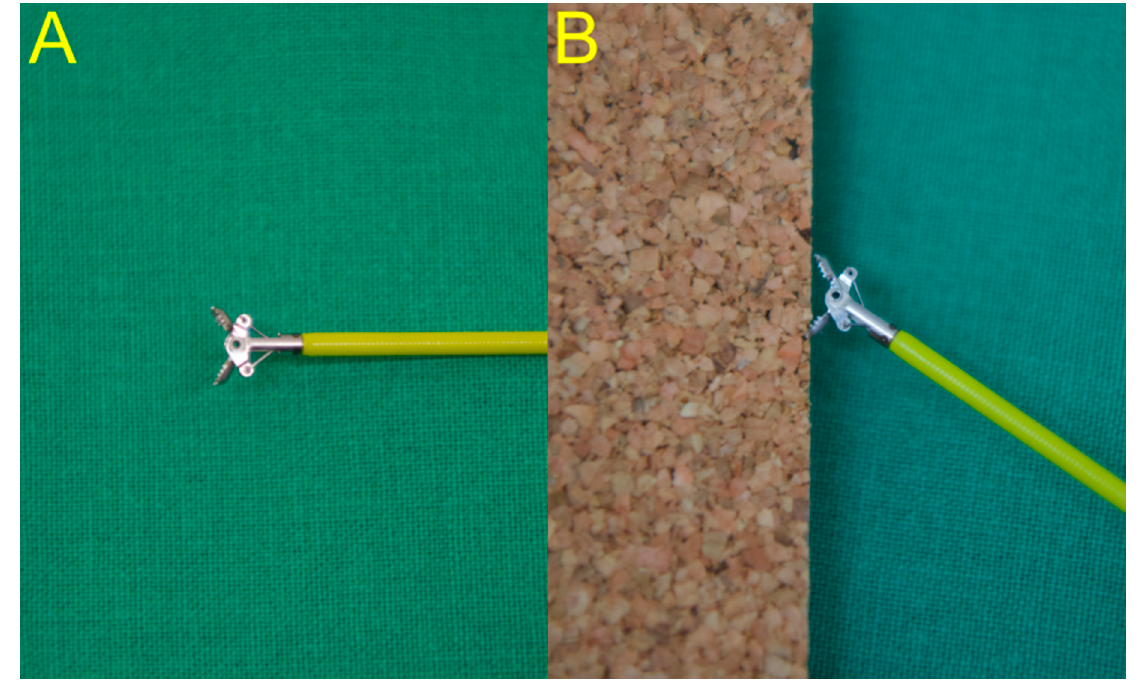
Figure 1. ( A ) The novel forceps have jaws that can open to a relatively wide angle. ( B ) The swing function can permit tangential biopsy even in an oblique approach angle, which minimizes the “bounce off” effect.